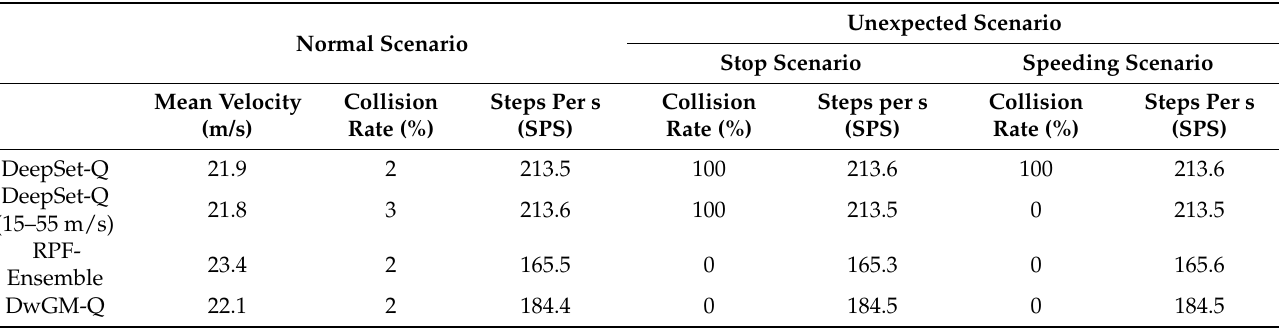
Table 2. Experiment Results.